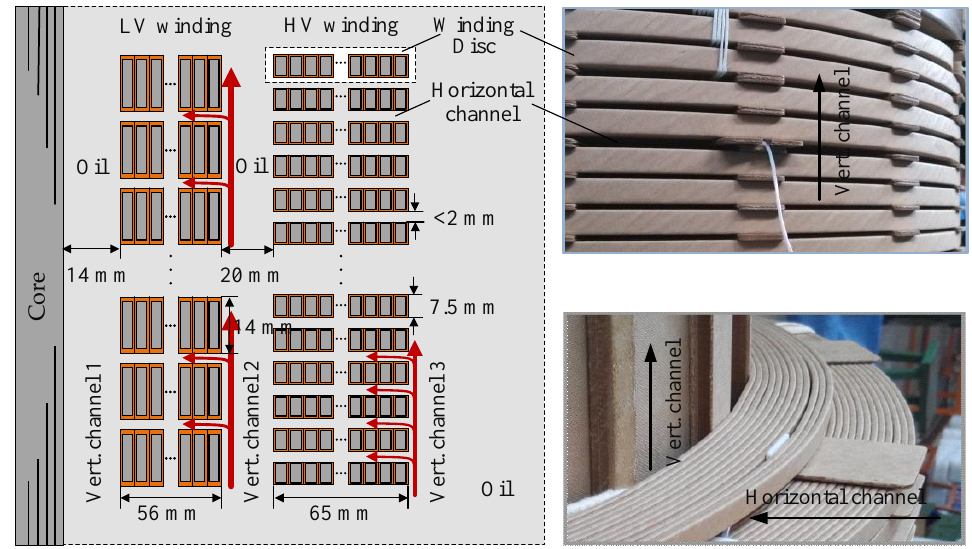
Figure 2. Transformer windings and oil